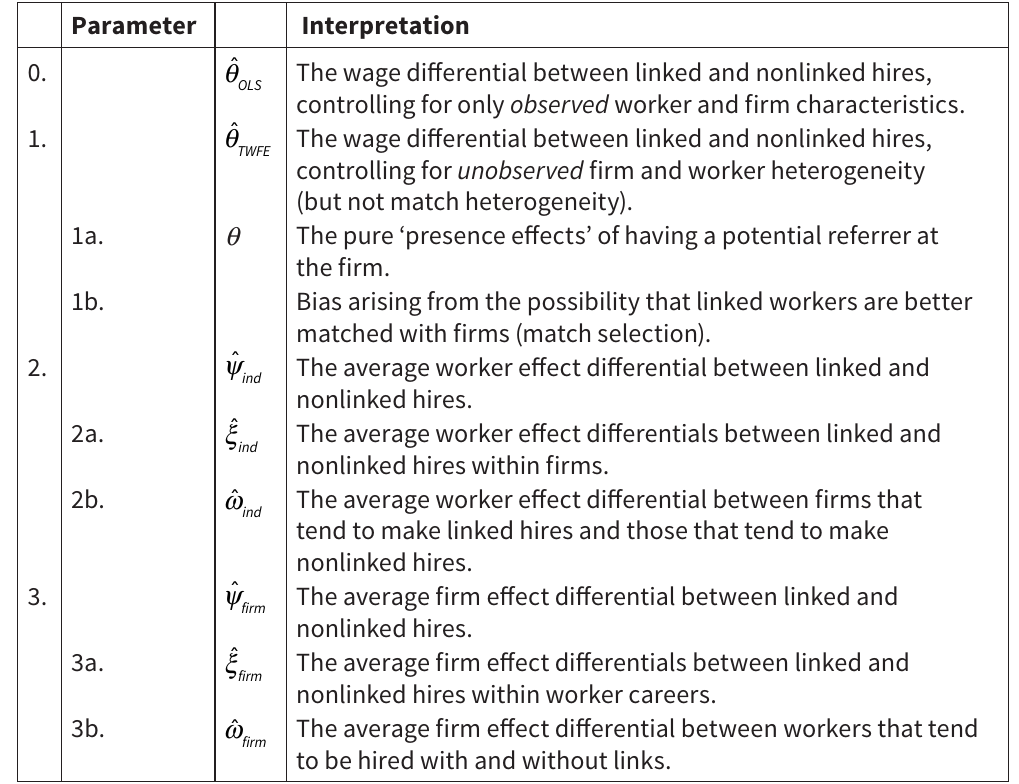
Summary of parameters in our model Parameter